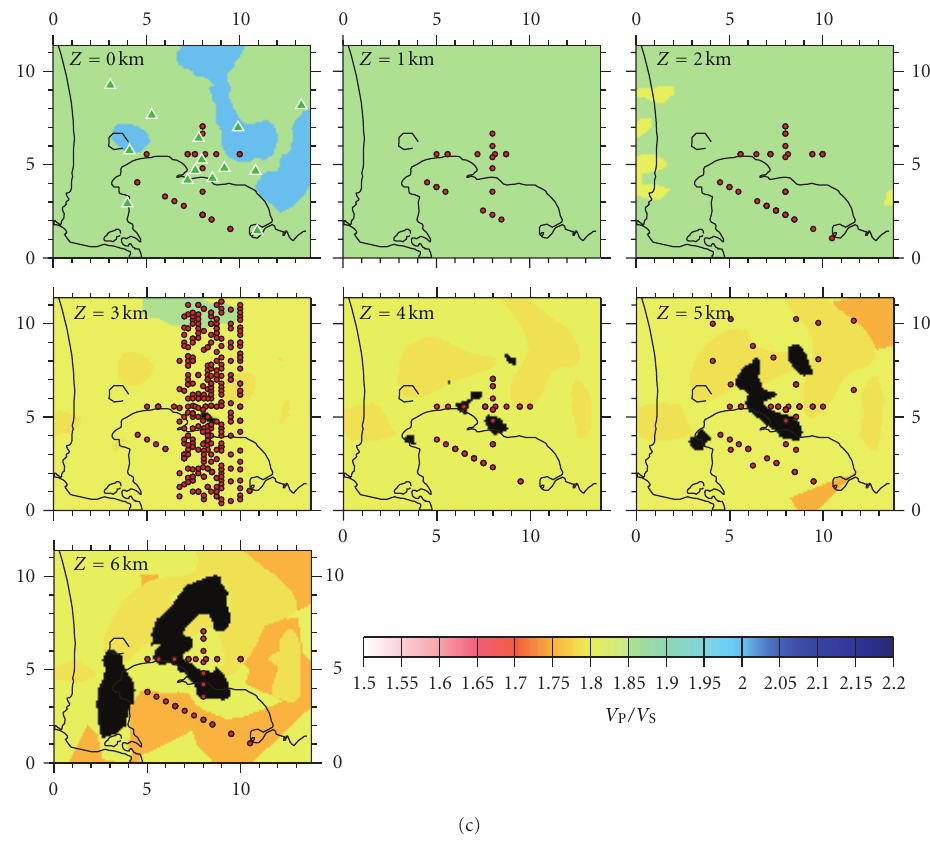
Figure 5: 3D model: V P (a), V S (b), and V P /V S (c) along horizontal